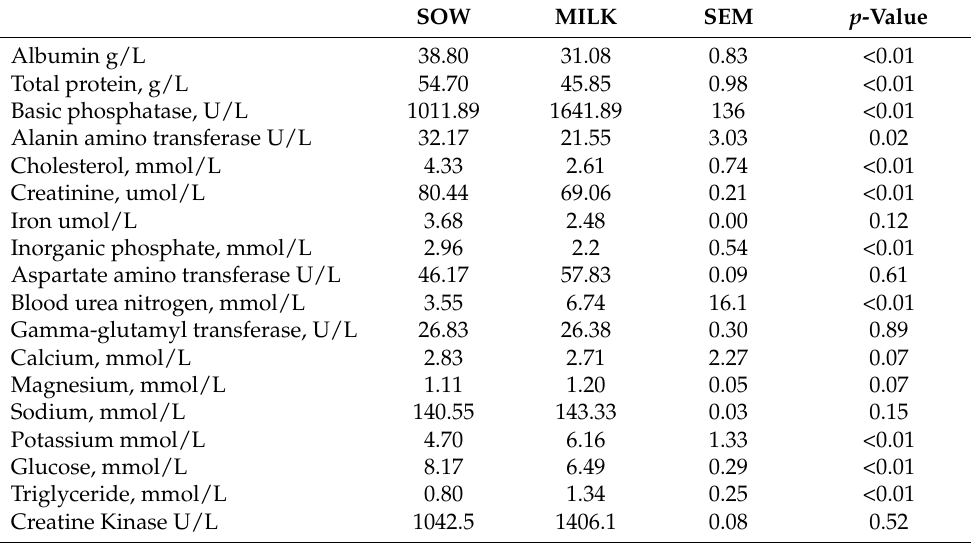
Table 9. Blood serum metabolites of sow (SOW) and artificially (MILK) reared piglets.